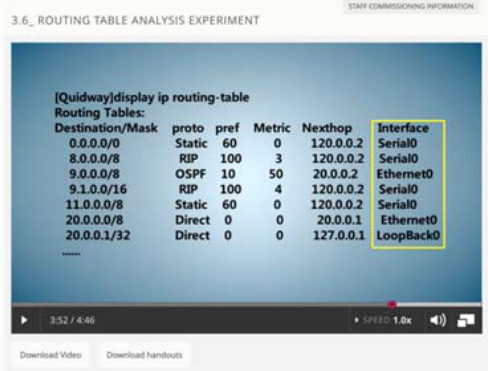
Figure 3. Video learning resources for network experiments.